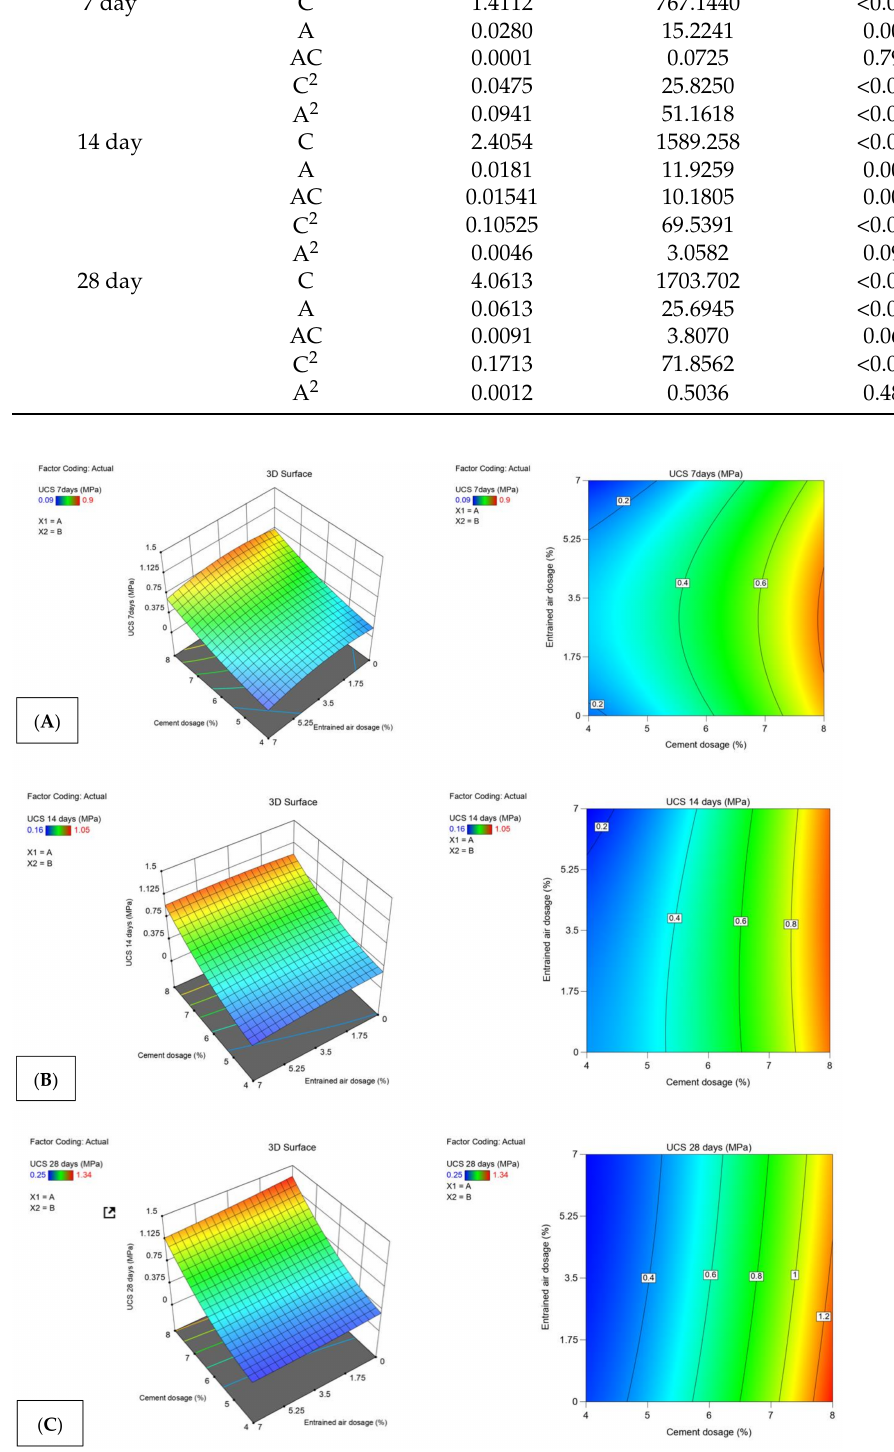
Figure 12. Response surfaces and contour plots for UCS models after curing backfill specimens for ( A ) 7 days, ( B ) 14 days, and ( C ) 28